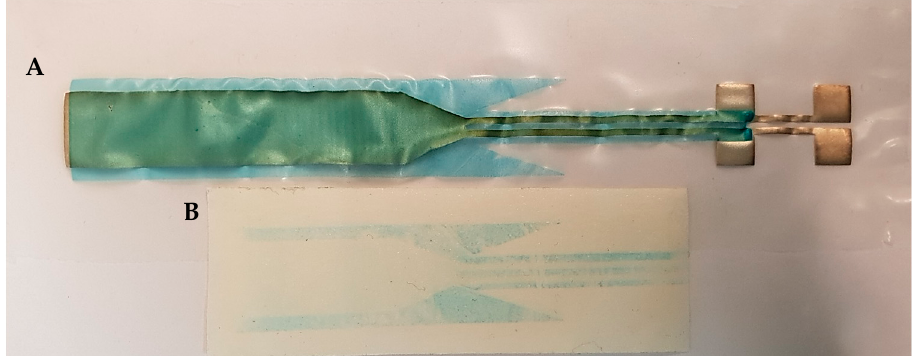
Figure 7. Peel test result. ( A ) The same sample after performing the peel test; ( B ) Tape used for the test. The blue trace indicates the poor adhesion between the substrate and the dielectric ink.